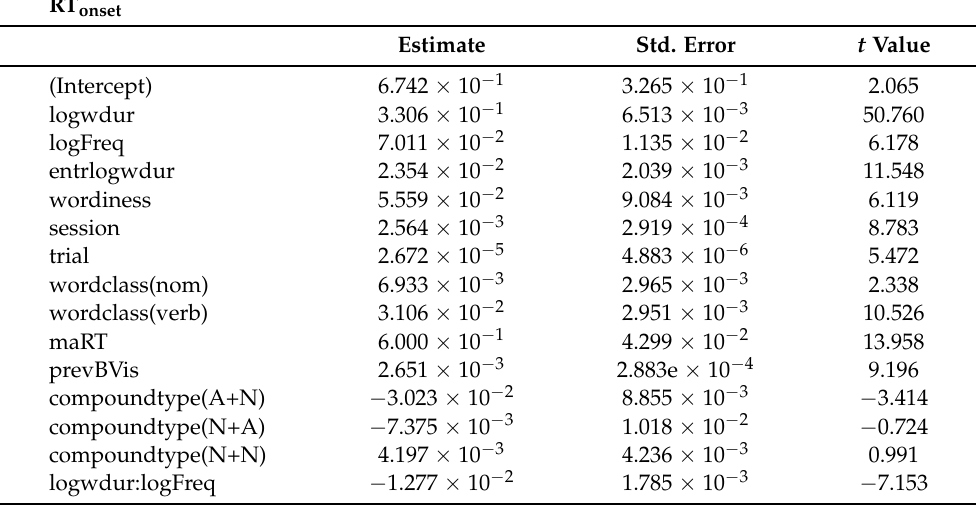
Table A1. Output of lmer model modeling RTonset, including the DIANA-based predictors entrlogwdur , which is the entropy residualized over log word duration, and wordiness . For details see the